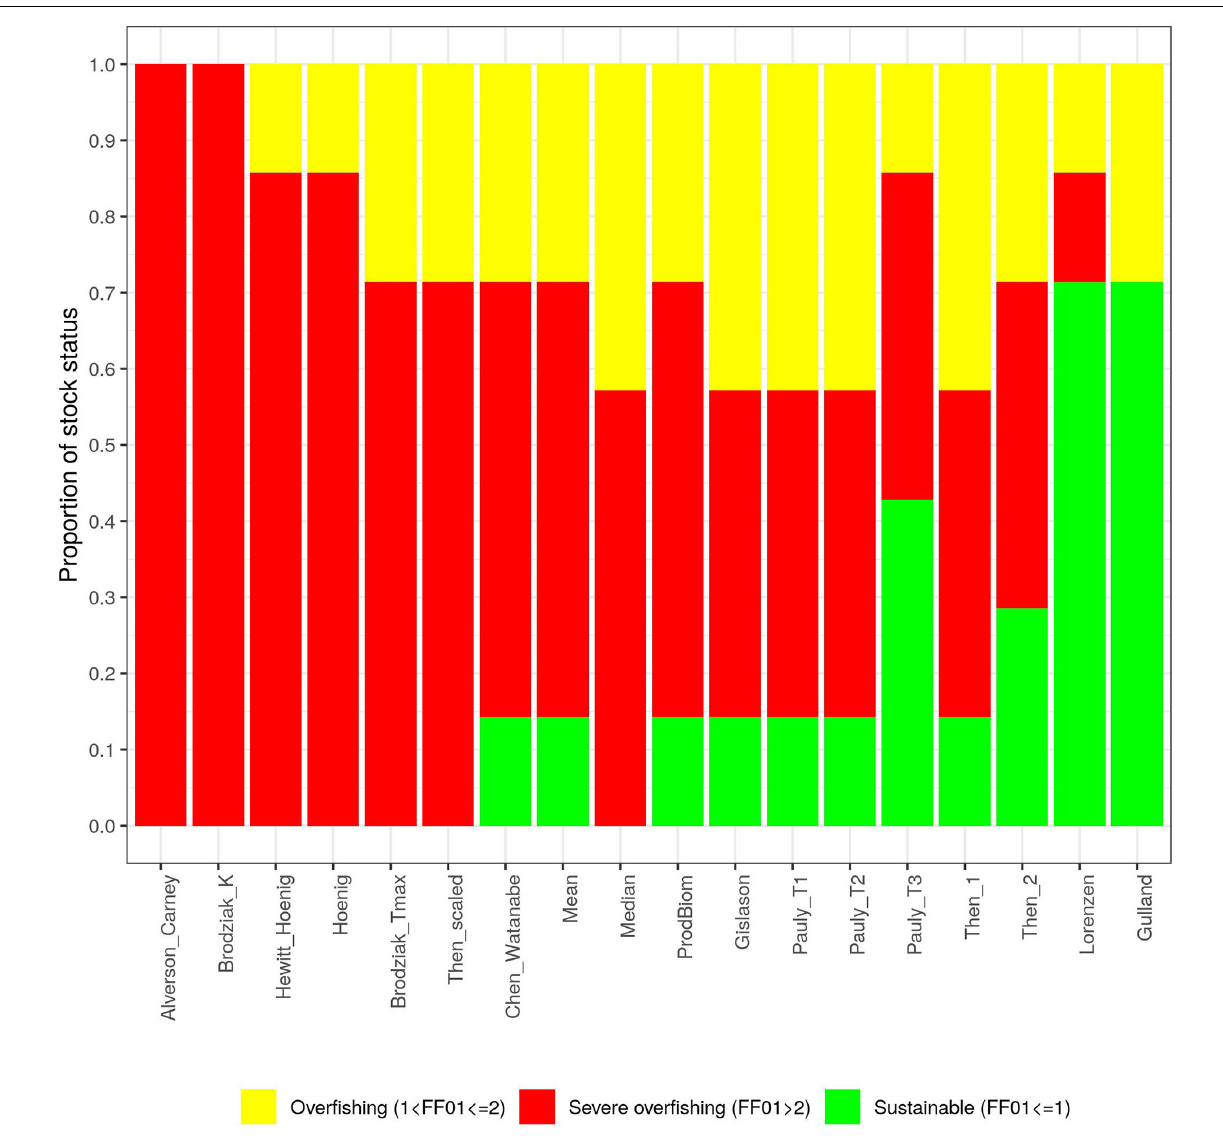
FIGURE 4 | Distribution of the ratios F curr /F 0 . 1 by stock. On the y axis is reported the proportion of stocks for each level of exploitation over the total number of cases